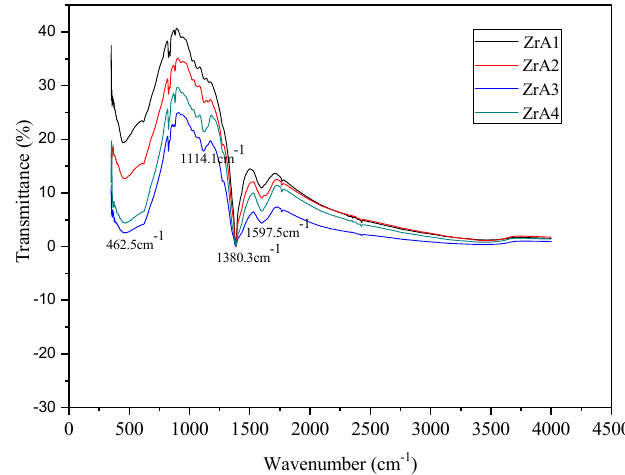
Fig. 2. (a)-(d): FTIR graphs for ZrNPS (a) ZO1 (b) ZO2 (c) ZO3 and (d) ZO4